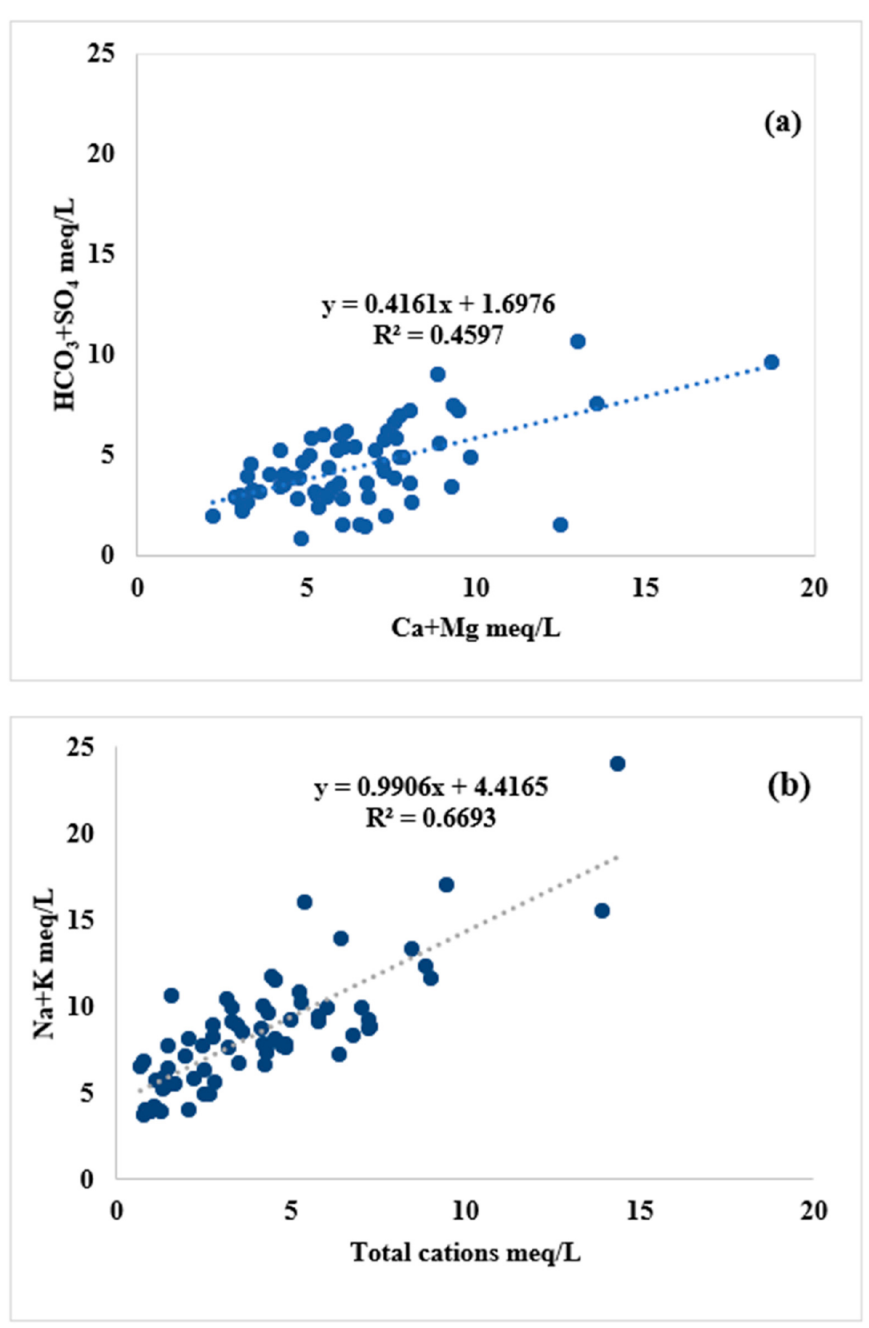
Figure 2. ( a ) Carbonate weathering triggering Ca ++ and Mg ++ in the groundwater. ( b ) Na + K versus total